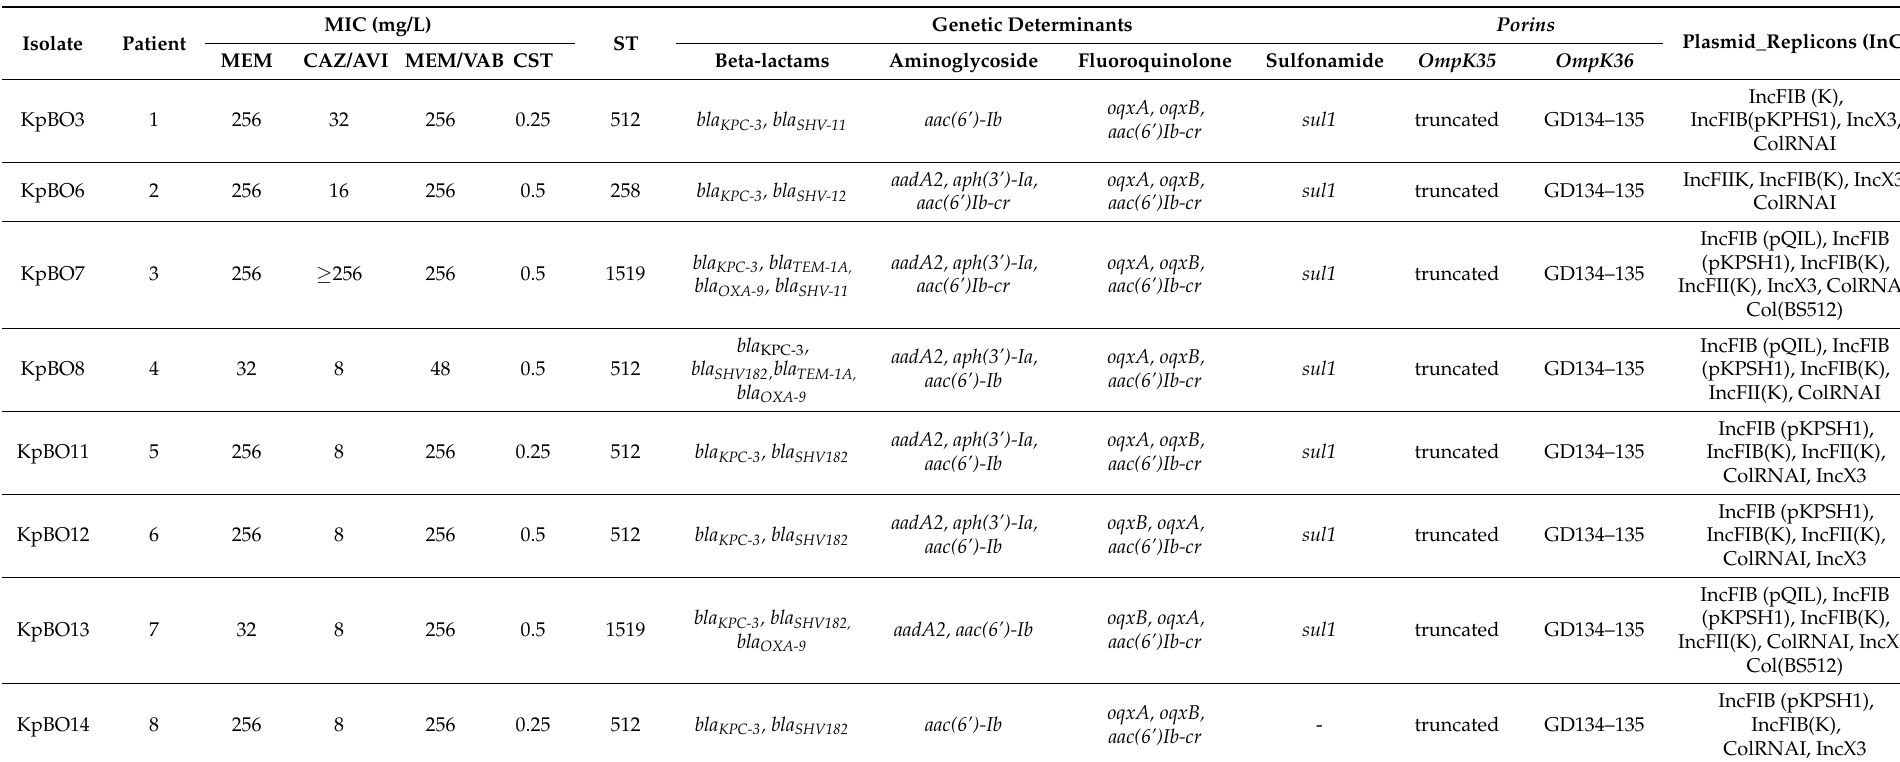
Table 1. Phenotypic and genotypic characteristics of meropenem/vaborbactam-resistant KPC-producing Klebsiella pneumoniae